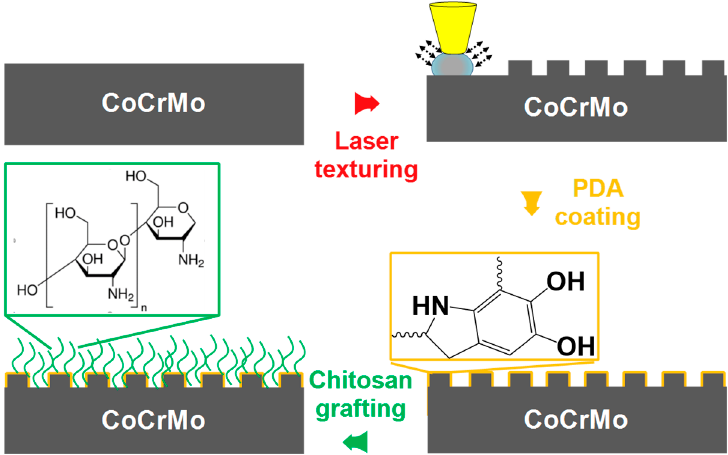
Figure 1. Schematic of polydopamine mediated immobilization for grafting chitosan onto the textured CoCrMo surface.